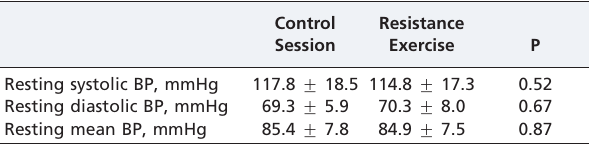
Table 2 - Pre-intervention blood pressure (BP) measured in the control and resistance exercise